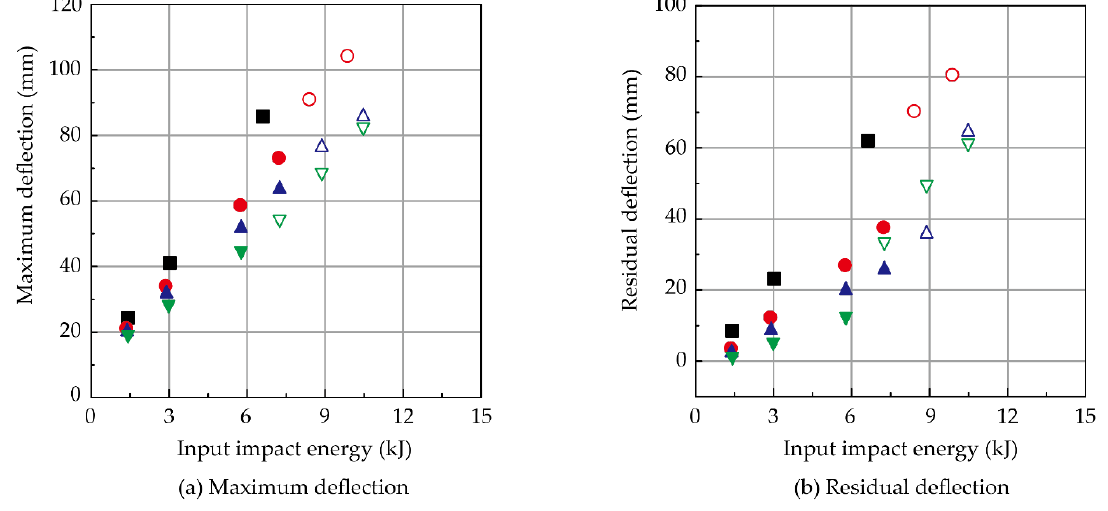
Figure 15. Relationships between maximum/residual deflection and input impact energy.